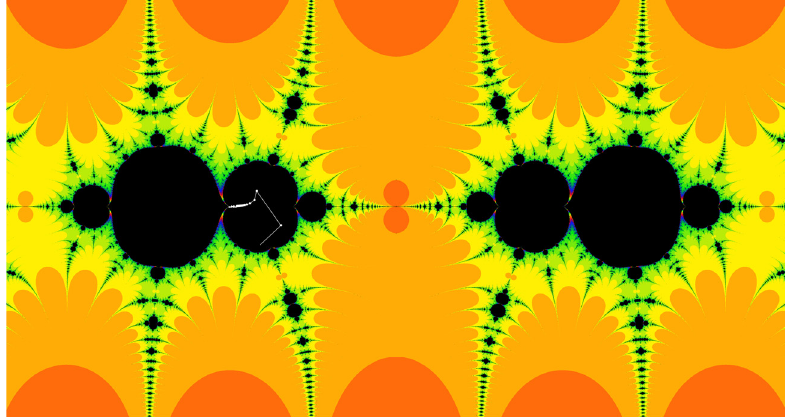
Figure 16: The attracting and parabolic domains in the Fatou set for λ −2 = and μ π 2 =